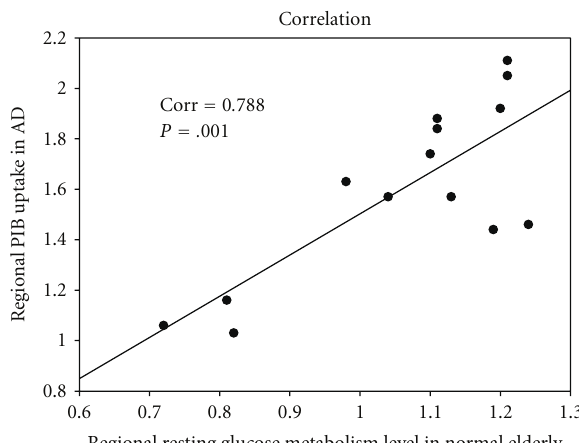
Figure 4: The relationship between resting glucose metabolism levels and PIB uptakes. The correlation between regional resting glucose metabolism in normal elderly subjects and regional PIB uptake in Alzheimer’s disease (AD) patients from various di ff erent brain areas is highly significant (0.788, P = . 001). This correlation demonstrates that brain regions with high resting glucose metabolism in normal elderly subjects have high PIB uptakes in AD patients and that brain regions with low resting glucose metabolism have low PIB uptakes in AD patients. Most importantly, it should be noted that resting glucose metabolism level and PIB uptake are correlated not only in the brain’s default network regions but also in brain regions outside the default